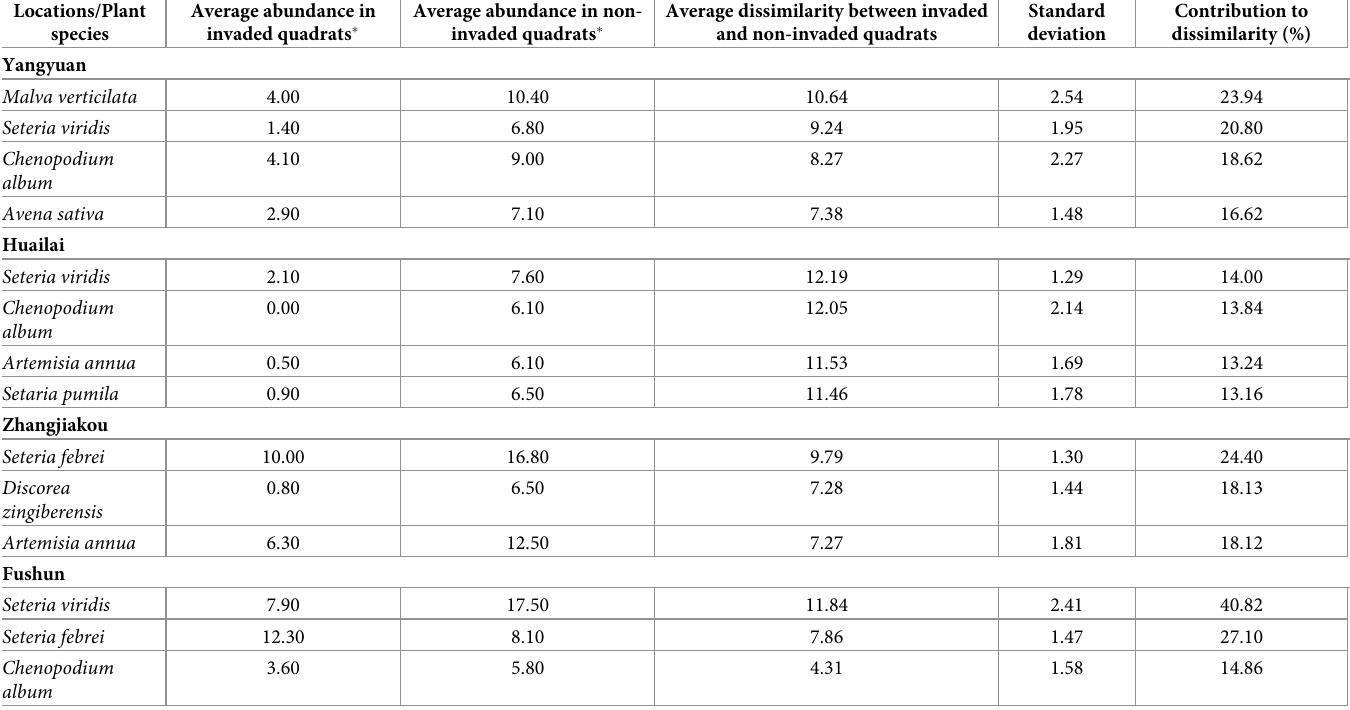
The plant species collectively explained 79.98%, 54.24%, 60.65% and 82.78% of the total dissimilarities in Yangyuan, Huailai, Zhangjiakou and Fushun, respectively. The total dissimilarities were 44.43, 87.06, 40.13 and 29.02 in Yangyuan, Huailai, Zhangjiakou and Fushun, respectively. Whereas � : 1 -rare, 2 -common, 3 -very common, > 4